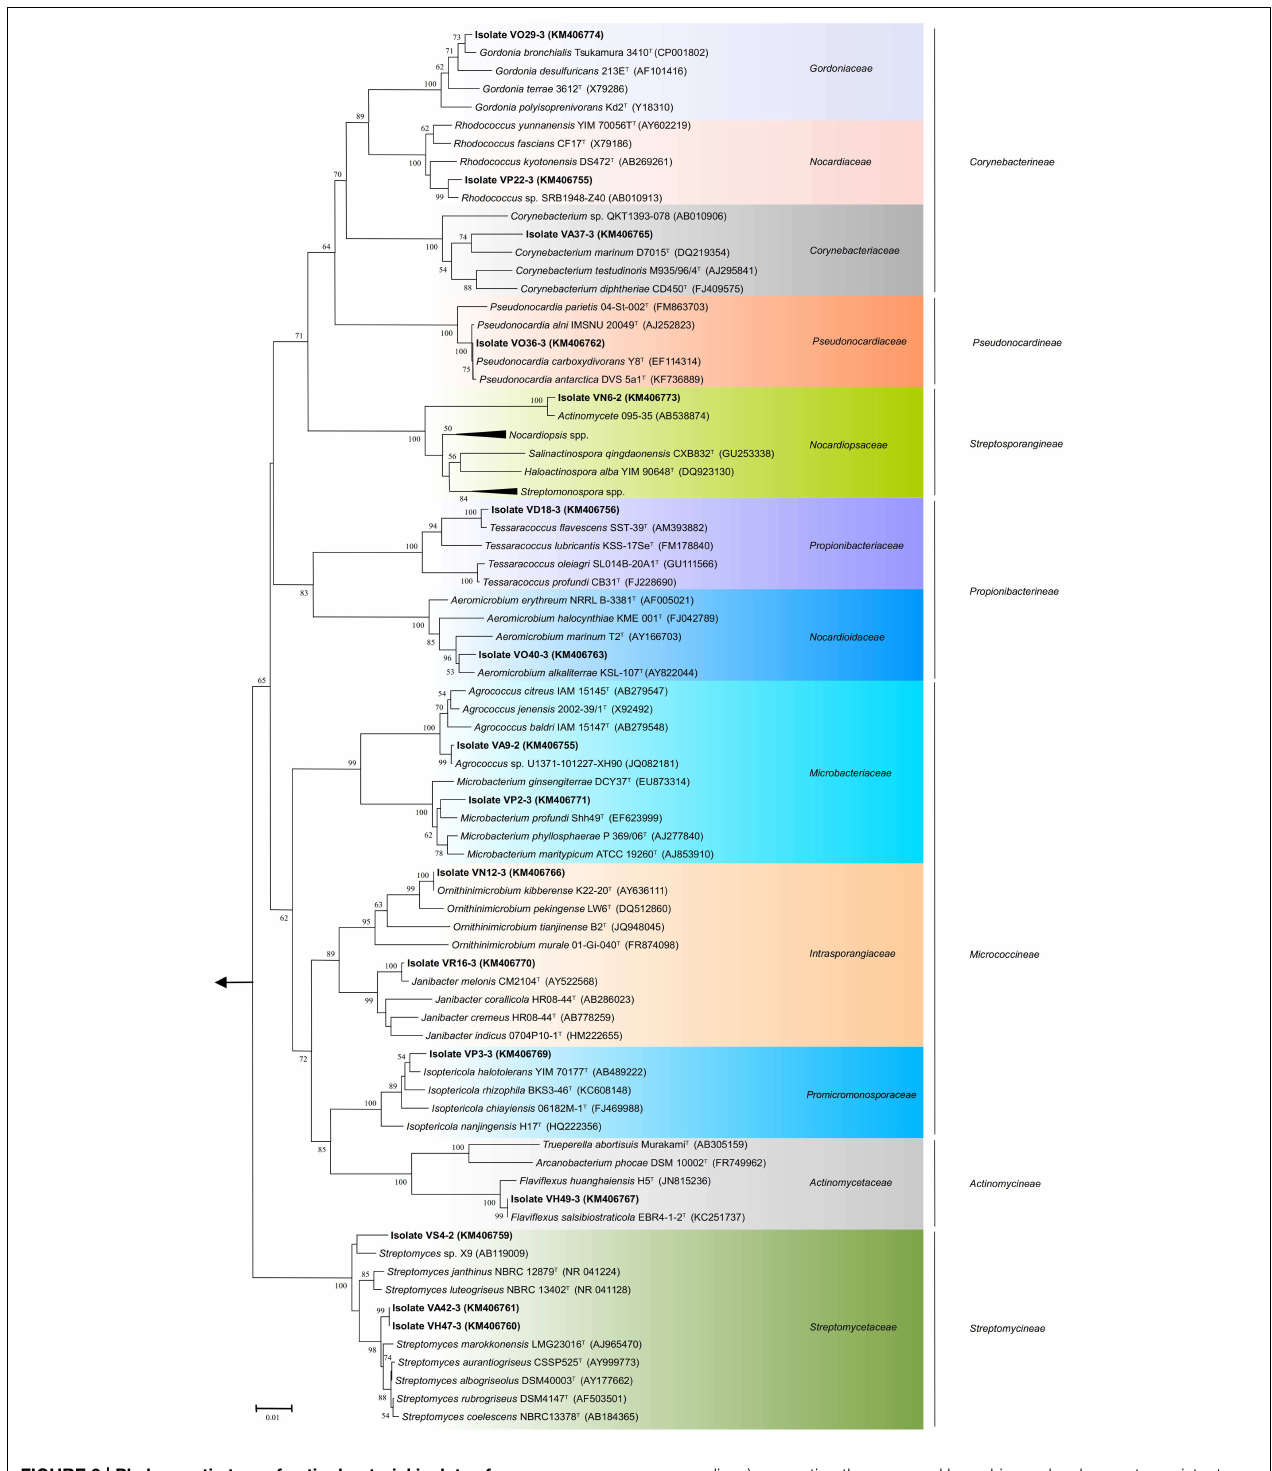
resamplings) supporting the proposed branching order shown at consistent nodes (values below 50% not shown). Gene sequence positions 101–1426 were considered, according to the Escherichia coli K12 16S rRNA gene sequence numbering. Arrow points to the outgroup E. coli K12 (AP012306). The GenBank accession numbers of 16S rRNA sequences are given in parentheses. Scale bar corresponds to 0.01 substitutions per nucleotide